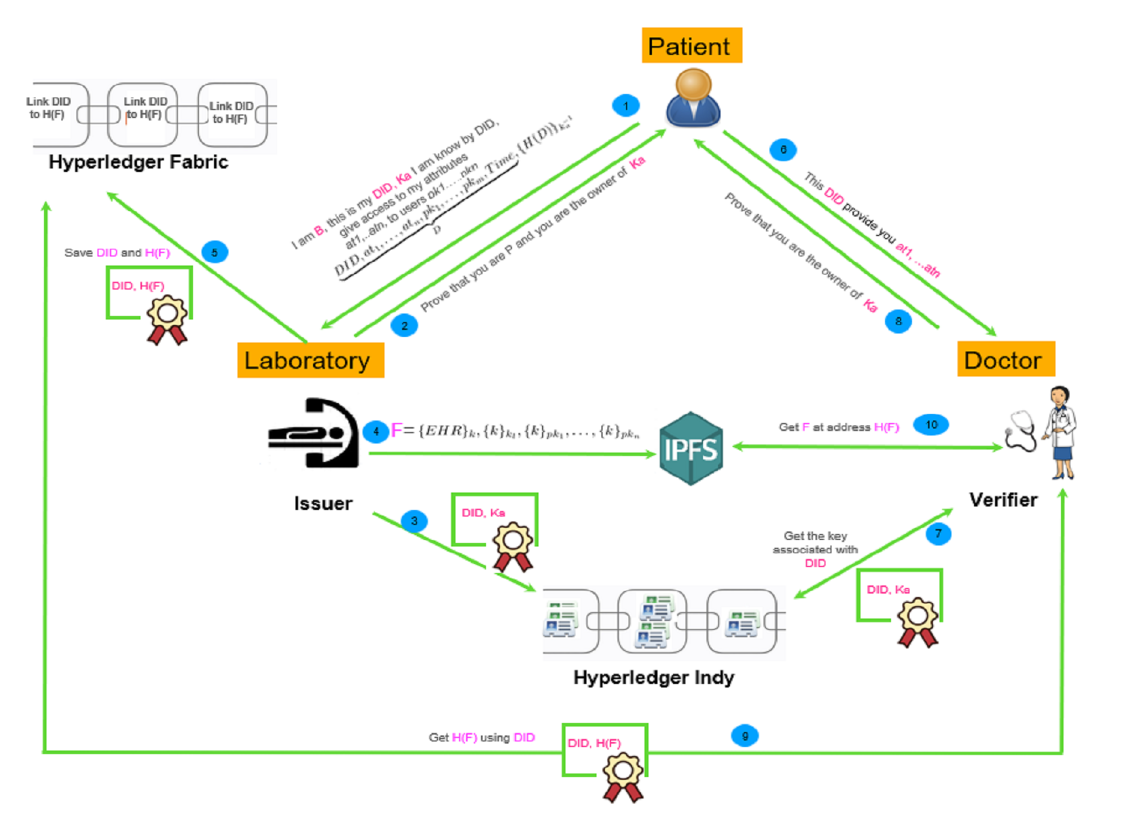
Figure 4. IPFS to enhance the security of